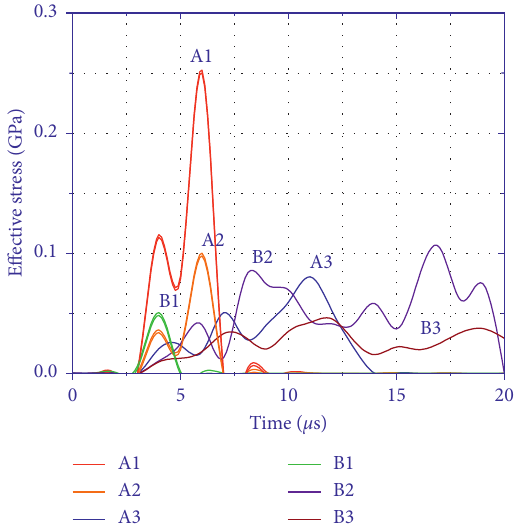
Figure 18: Comparison of maximum stress curves.